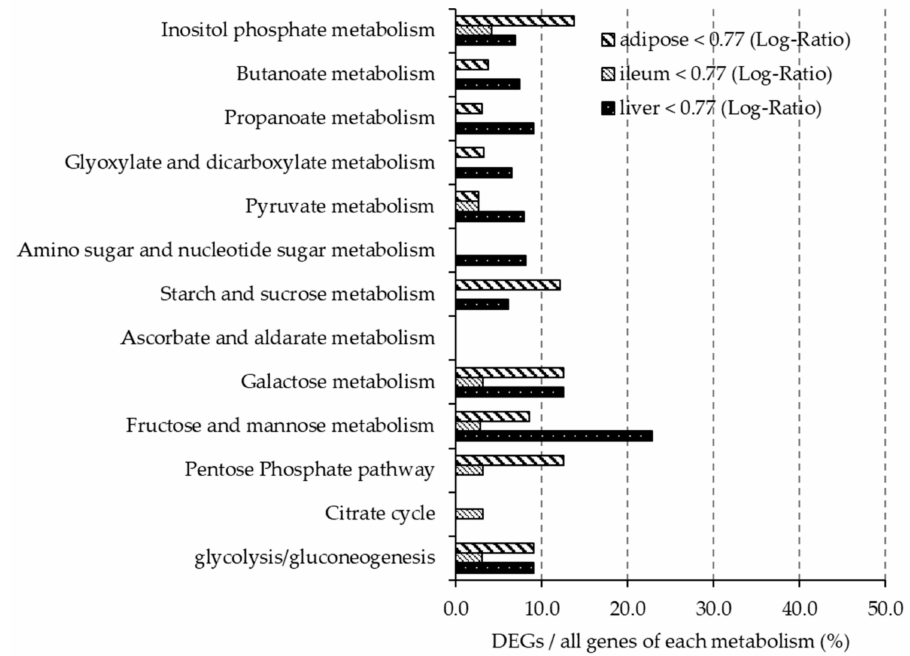
Figure 5. In mice fed the BF diet, the ratio of DEGs downregulated (gene expression < 0.77-fold di ff erence compared with the control group) in each organ is shown. The y -axis shows the carbohydrate metabolic pathway described in KEGG. The x -axis shows the percentage of DEGs of all genes involved in each metabolic